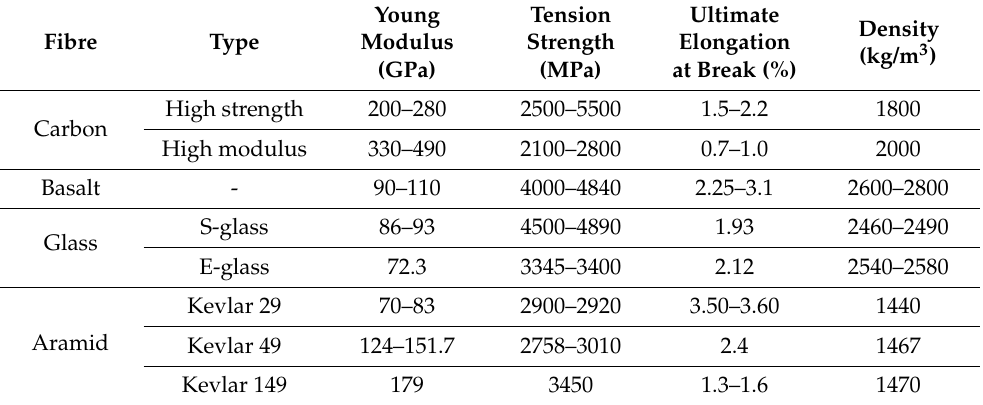
Table 1. Properties of the major fibres used in FRP composites, adapted from [18–30].